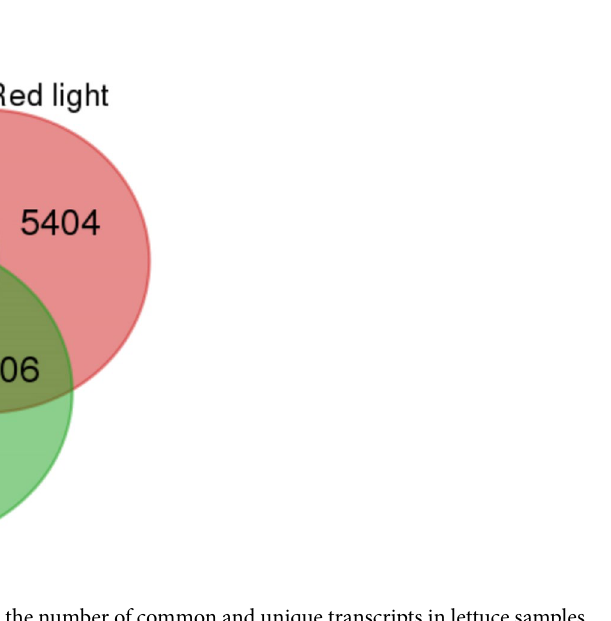
Figure 1. Venn diagram representing the number of common and unique transcripts in lettuce samples grown under blue, red, and white light. Only those transcripts expressed with a minimum TPM value of 1 were